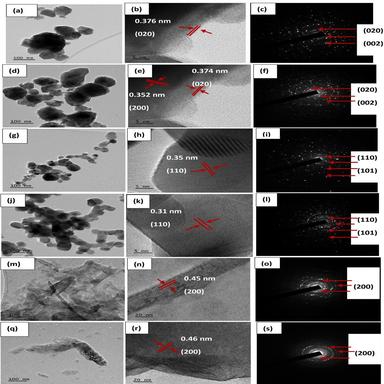
HR-TEM micrographs of WO3 (a, b), WO3-Co (d, e), SnO2 (g, h), SnO2-Co (j, k), VO2 (m, n), VO2-Co (q, r) SAED of WO3 (c), WO3-Co (f), SnO2 (i) SnO2-Co (l), VO2 (o), VO2-Co (s). (For interpretation of the references to colour in this figure legend, the reader is referred to the web version of this article.)